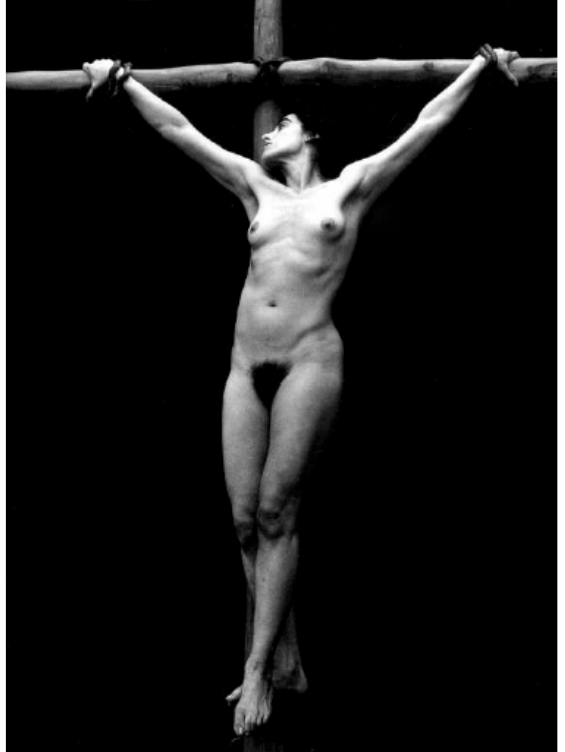
Figure 12. Annie Leibovitz, Diamanda Galás , 1991, gelatin silver print, 38.1 × 31.75 cm.